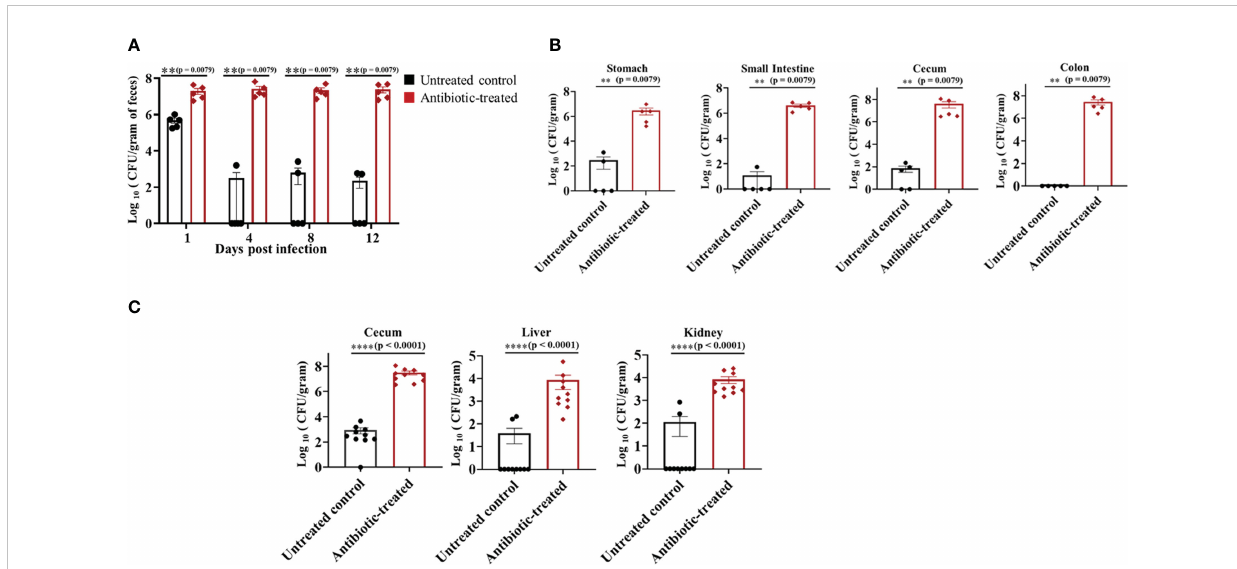
FIGURE 1 Oral antibiotic treatment increased C. auris colonization in the gastrointestinal tract of mice. Groups of mice were pre-treated with either sterile drinking water (untreated control group) or cefoperazone for 7 days and infected with C. auris 0387 strain via oral gavage. Antibiotic-treatment was continued till the end of the experiment. (A) Fungal load in the fecal pellets collected on indicated days and colony forming units (CFU) were determined by plating the contents onto YPD agar containing antibiotics (ampicillin, kanamycin, and streptomycin). C. auris colonies were further con fi rmed by plating onto chromagar plates. (B) After 12 days, mice were euthanized and gut contents collected were used to determine the fungal load in stomach, small intestine, cecum and colon. Data are presented as mean ±SEM with n = 5 mice for each group. (C) Untreated and antibiotic- treated mice were infected with C. auris and treated with cyclophosphamide. After 5 days of infection, mice were euthanized to determine the fungal load in cecal contents, liver and kidney. The bars indicate the mean ±SEM with n = 10 mice for each group. Statistical signi fi cance was calculated using Mann-Whitney U test. ** p ≤ 0.01; **** p ≤